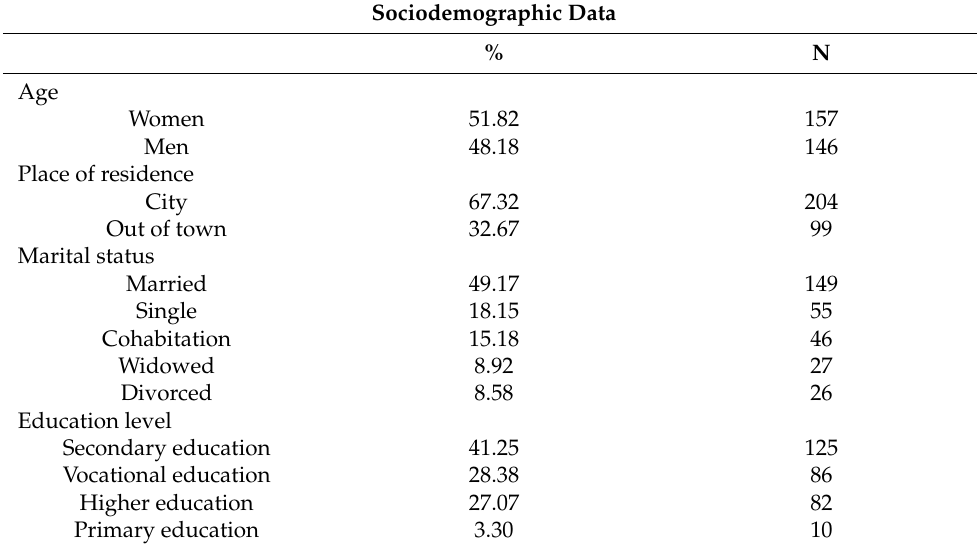
Table 1. Sociodemographic data.